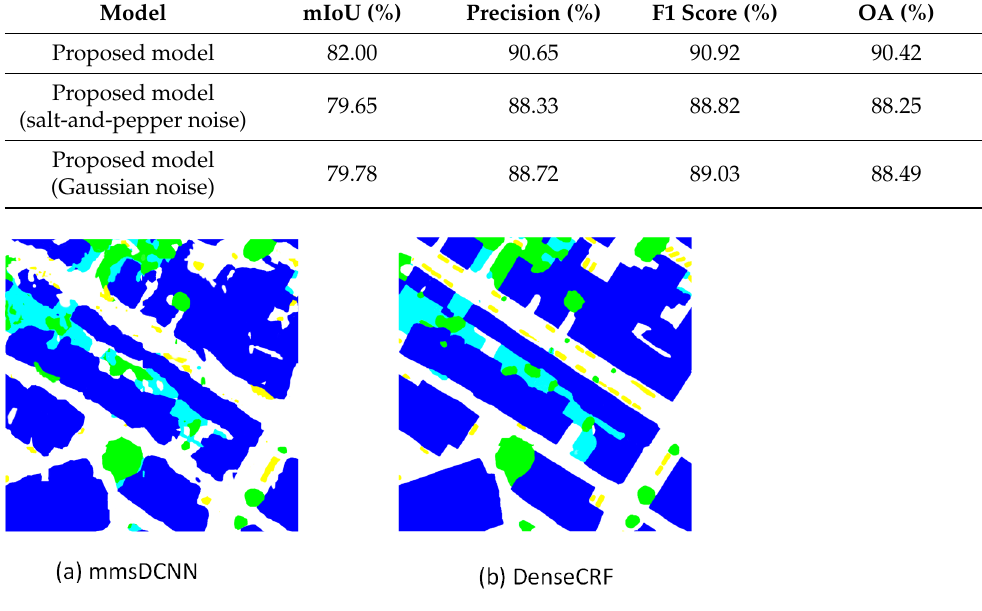
Figure 9. The initial segmentation of the mmsDCNN and the segmentation map as estimated from the DenseCRF.